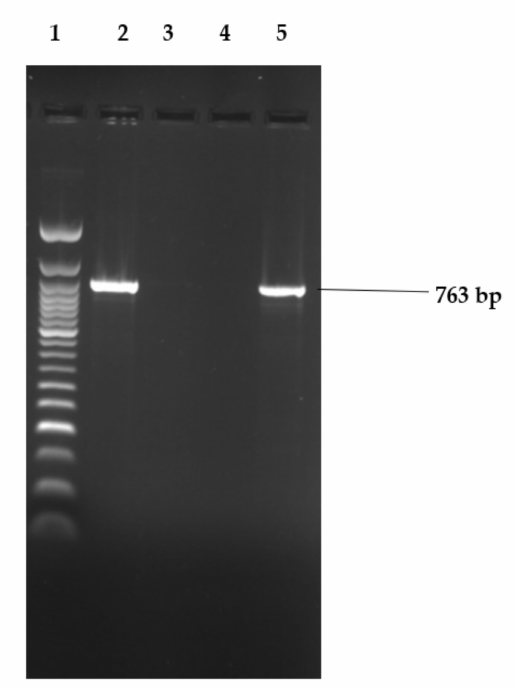
Figure 4. Image showing electrophoresis results for sivH gene